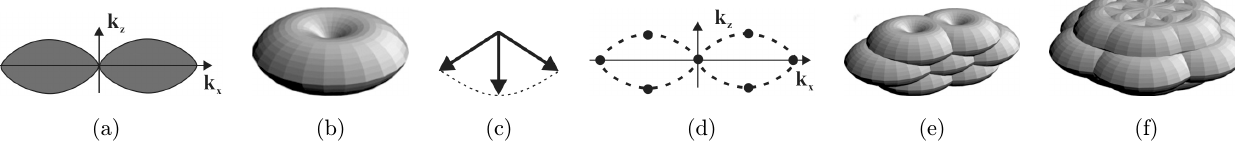
Fig. 5. Extension of the observable region of reciprocal space through three-dimensional structured illumination. 12 Observable regions for (a) and (b) the conventional microscope. (c) The three amplitude wave vectors corresponding to the three illumination beam directions. (d) The resulting spatial frequency components of the illumination intensity for three-beam, and observable regions of three illumination beams in one (e) or three (f) sequential